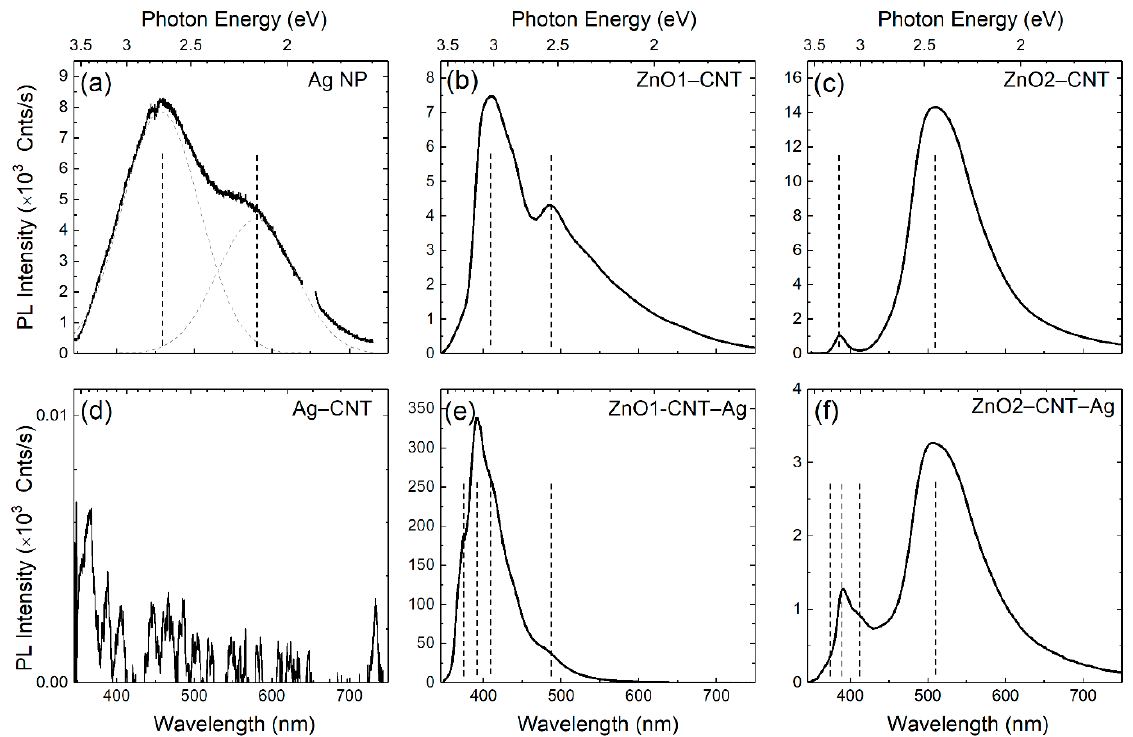
Figure 5 . PL emission spectra of ( a ) pure Ag NPs, ( b ) ZnO1–CNT, ( c ) ZnO2–CNT, ( d ) Ag–CNT, ( e ) ZnO1–CNT–Ag and ( f ) ZnO2–CNT–Ag nanohybrids. Vertical dashed markers indicate major emission components discussed in the text.